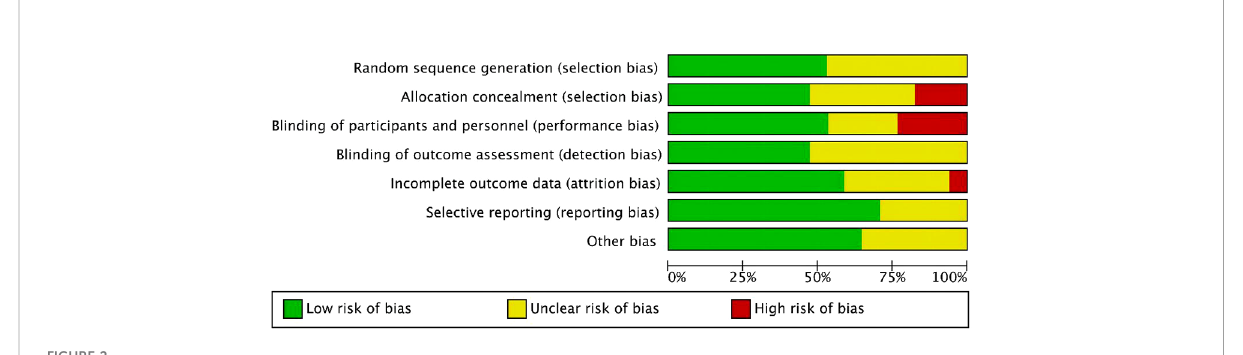
FIGURE 2 Risk of bias and applicability concerns